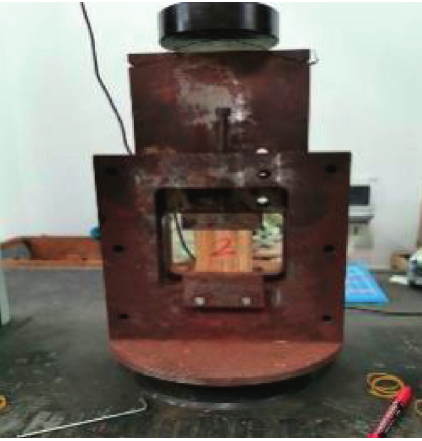
Figure 6: Device for shear test. Table 1: Summary of basic material properties.